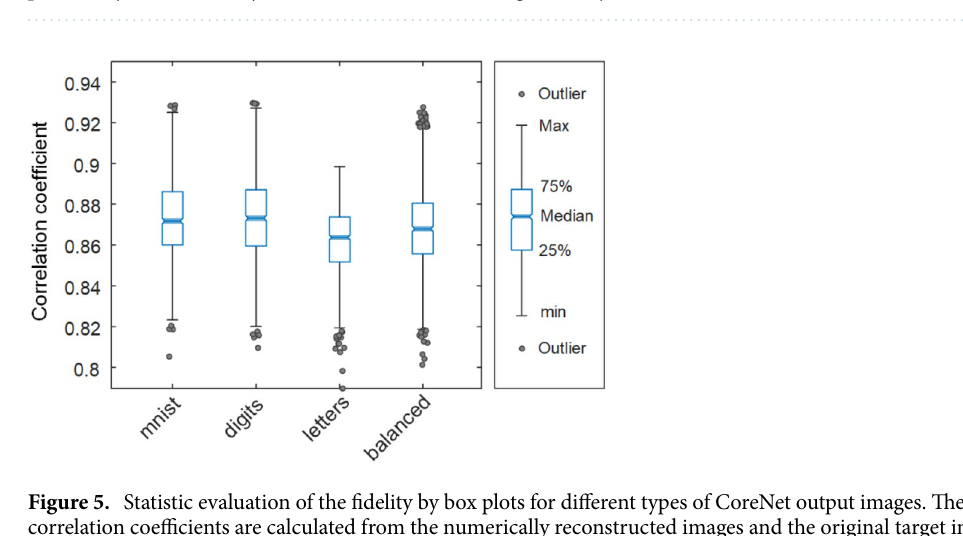
Figure 4. Real-time holographic display through a lensless microendoscope using CoreNet. ( a ) Schematic demonstrates the principle of controlled light field generation through a 50 cm long lensless microendoscope. ( b ) Sketch of the experimental setup. The Zoomed-in area demonstrates the controlled light field generation at the distal far-field. The phase hologram is generated by CoreNet and projected on the proximal facet of the microendoscope. HWP half-wave plate, PBS polarizing beam splitter cube, L1–L8 lenses, BS1-3 beamsplitter cube, QWP quarter-wave plate, SMF single-mode fiber, M mirrors, SLM spatial light modulator, ID iris diaphragm, PL polarizers, ND neutral density filters, CAM1-2 cameras, MO1-2 microscope objectives. ( c ) Video-rate tailored light field generation of a running man animation at 700 μm away from the distal fiber facet (see Supplementary Movie 1). The tailored holograms are real-time generated by CoreNet and loaded to the phase-only SLM on the fly. The scale bar indicates a length of 20 μm.